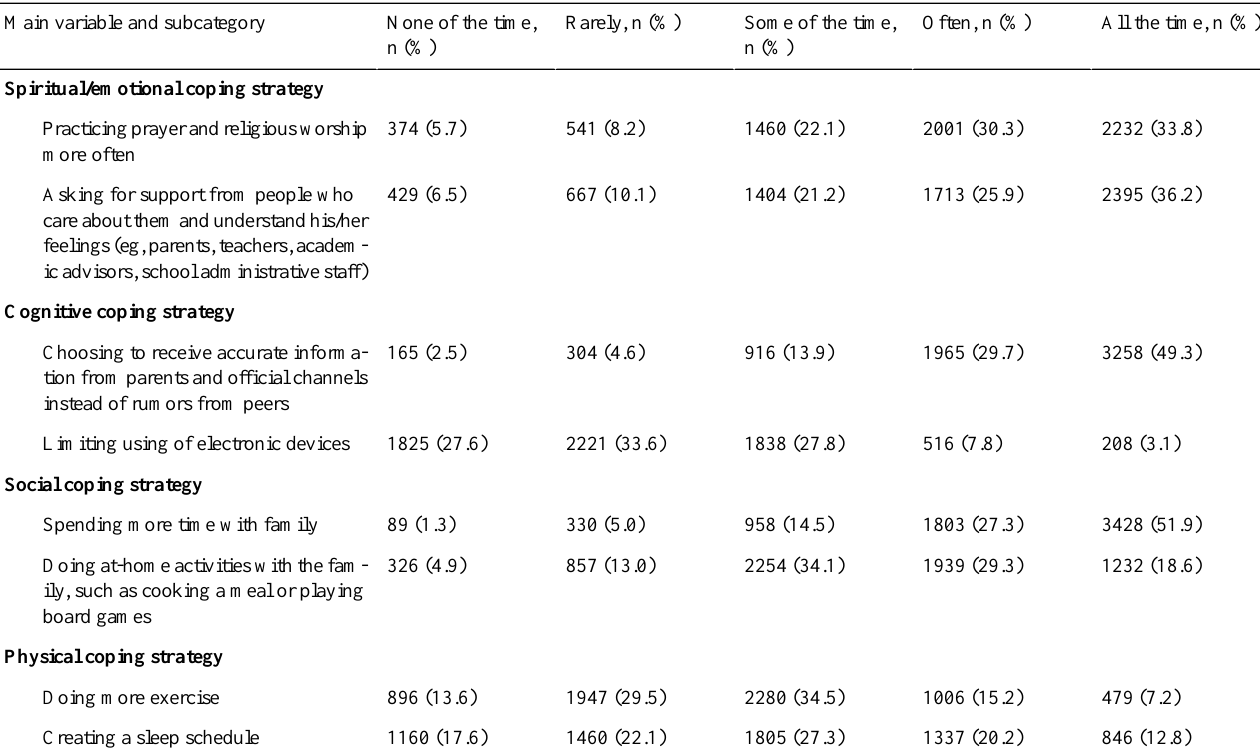
Table 3. Frequency distribution of symptoms related to each coping strategy used among children and adolescents during home isolation and social distancing due to the COVID-19 pandemic in Qatar in 2020 (N=6608). (%)Main variable and